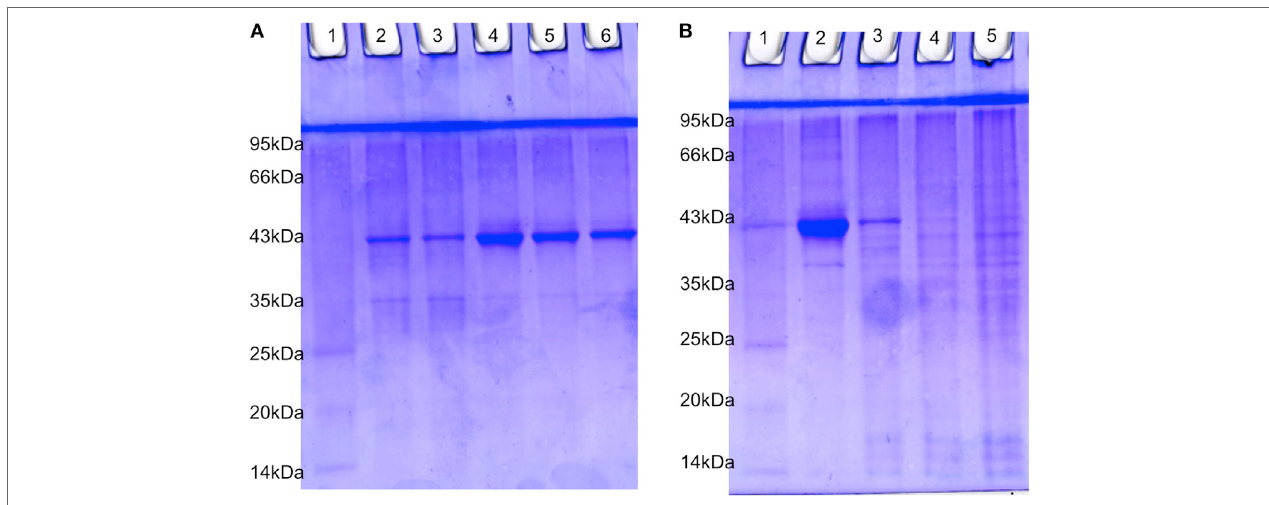
FigUre 7 | SDS-PAGE analysis of 15 µg protein extracted from (a) RS-307 strain of Acinetobacter baumannii cultured in Dulbecco’s Modified Eagle Medium (Lane 2, 3) and RS-307 cocultured and isolated from A-549 cell line, i.e., internalized bacteria (Lane 4–6). (B) A-549 cell line (Lane 2) as well as A-549 cell line infected with carbapenem-resistant strain RS-307 of A. baumannii (Lane 3–5). Lane 1 of both the gels represent protein